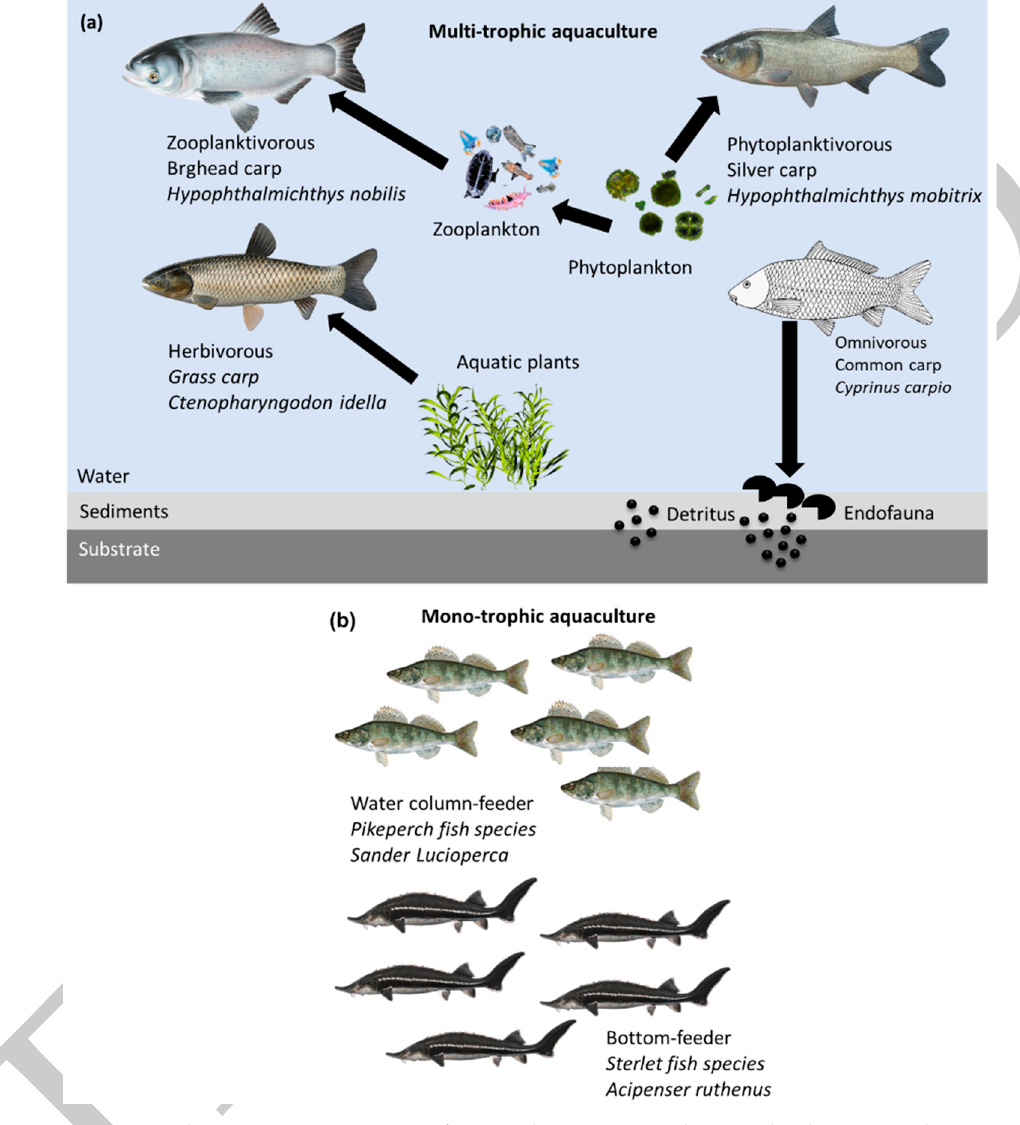
Figure 1. Schematic representation of aquaculture systems that involve basic complementarity. ( a ) Multi-trophic aquaculture involving unfed species based on the discrete trophic levels accessible in a farm setting, e.g., conventional aquaculture pond systems of carp species. ( b ) Mono-trophic aqua- culture system involving two fed-fish species with the same trophic-level food resources (formulated feed pellets), e.g., open cage systems or RASs.